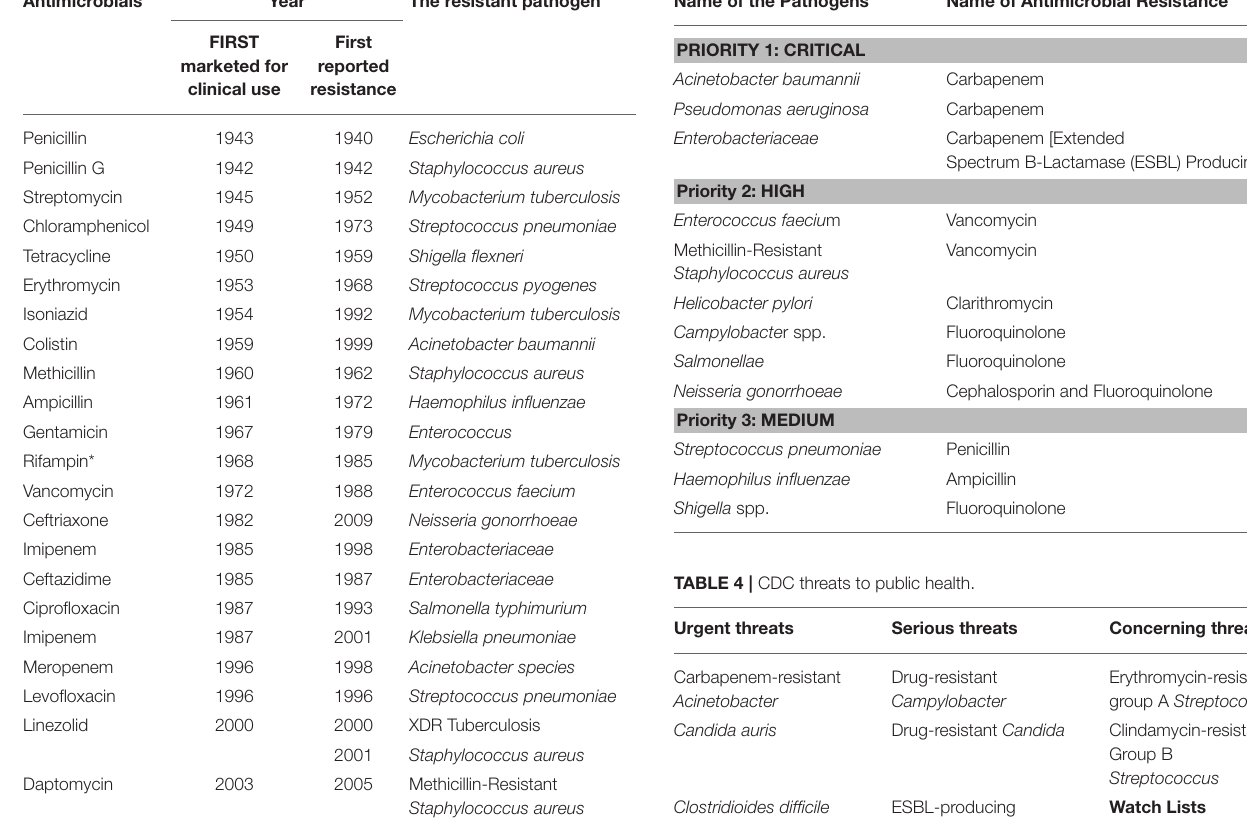
TABLE 3 | WHO priority list: infectious micro-organisms for research and development of novel antimicro bials. Name of the Pathogens